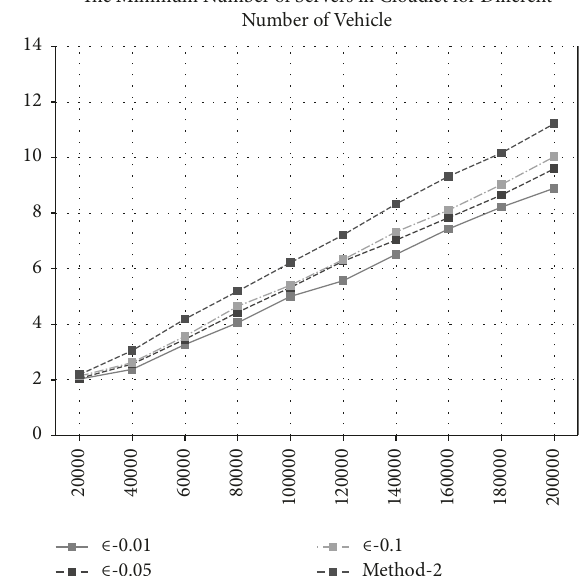
Figure 13: The minimum number of servers in Cloudlet for dif- ferent numbers of vehicles.